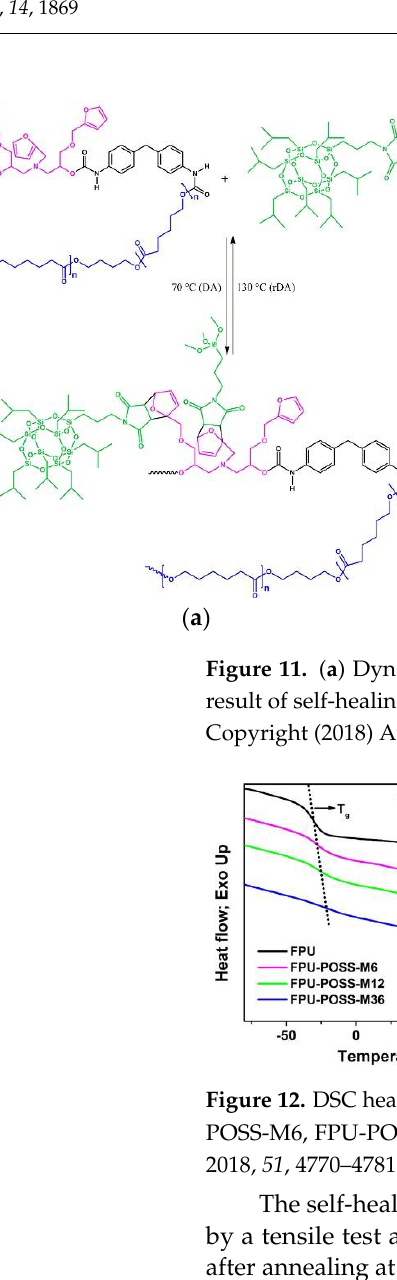
Figure 13. FESEM images of ( a ) native FPU and hybrid composites: ( b ) FPU-POSS-M6, ( c ) FPU- POSS-M12, and ( d ) FPU-POSS-M36. Reprinted with permission from Macromolecules 2018, 51 , 4770 – 4781 [74] Copyright (2018) American Chemical Society. The self-healing characteristics of this organic – inorganic hybrid SHM were evaluated by a tensile test and also by monitoring the crack disappearance by optical microscopy after annealing at 130 °C for 3 h, then cooling to 70 °C and maintaining at this temperature for 15 h. Heating at 130 °C caused cleavage of the DA adducts. The bonds reconnected via the DA reaction, which occurred at 70 °C, and the scratch was healed. In the case of FPU, the scratch remained visible after the healing process, whereas the addition of POSS-MI resulted in some enhancement of the self-healing properties even after the thermal treat- ment was stopped. An additional slight change in the scar could be noted. For the FPU- POSS-MI hybrids, almost no change in the surface roughness value (±3 nm) was observed after the healing process. The presence of POSS also improved the thermal and mechanical characteristics com- pared to those of pure FPU (Figure 14). The FPU-POSS-MI hybrid exhibited higher tensile strength and higher tensile modulus. Although the addition of POSS-MI increased the self-healing efficiency because of the formation of thermoreversible DA adducts, the